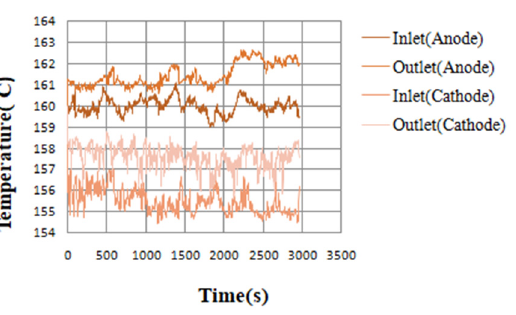
Figure 6. Pressure variation chart of different positions of the high-temperature fuel cell. Table 1. Test conditions of the high-temperature fuel cell.